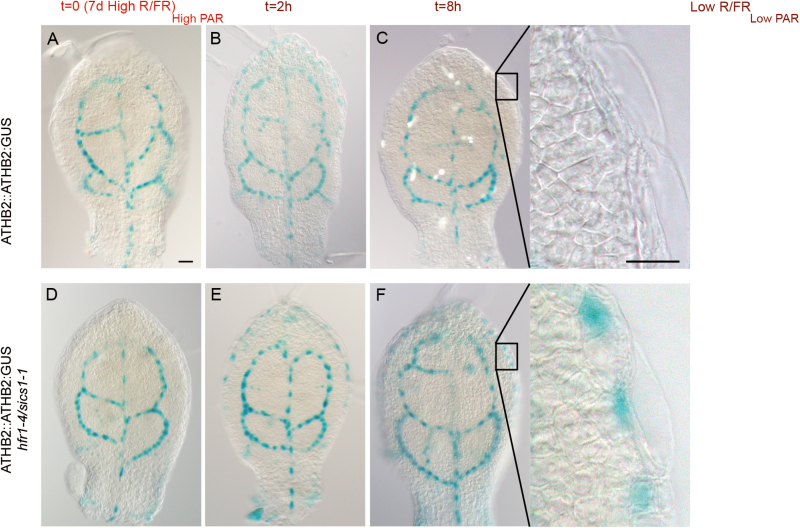
ATHB2 expression is induced in the leaf margin by shade. (A–F) Histochemical localization of GUS activity in first and second leaves of ATHB2::ATHB2:GUS (A–C) and ATHB2::ATHB2:GUS hfr1-4/sics1-1 (D–F) seedlings grown for 7 d in a light/dark cycle (16/8 h) in High R/FRHigh PAR (A, D), and then exposed to Low R/FRLow PAR under the same regimen for 2 h (B, E) and 8 h (C, F). The insets show a paradermal view of adaxial epidermal cells. At least 30 leaves for each line and each time point were analysed. Scale bars: (A–F), 50 μm; insets, 10 μm.